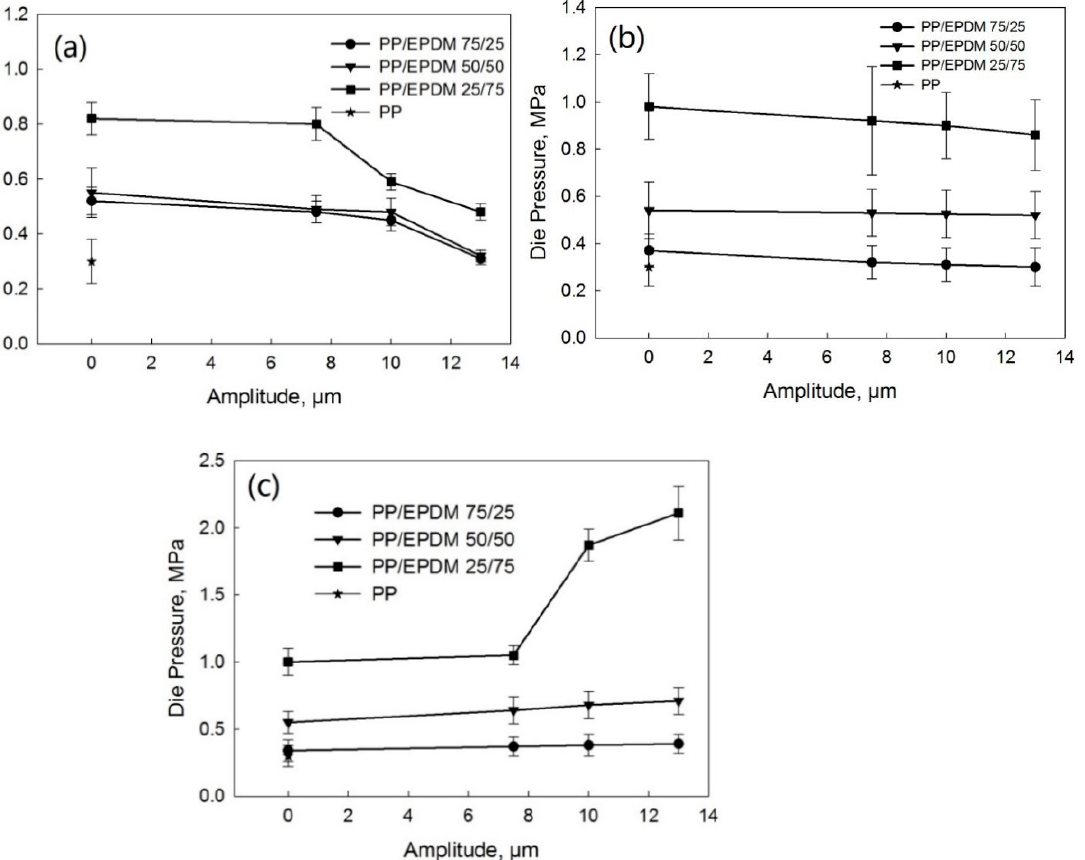
Figure 3. Die pressure as a function of the ultrasonic amplitude of the PP/EPDM blends prepared by the OS ( a ), TS ( b ), and DR ( c ) methods. Die pressure for pure PP is also indicated.